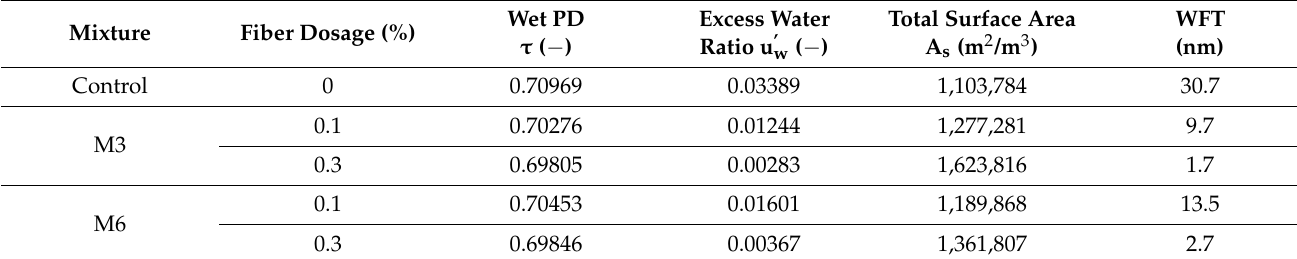
Table 5. Effect of fiber addition on